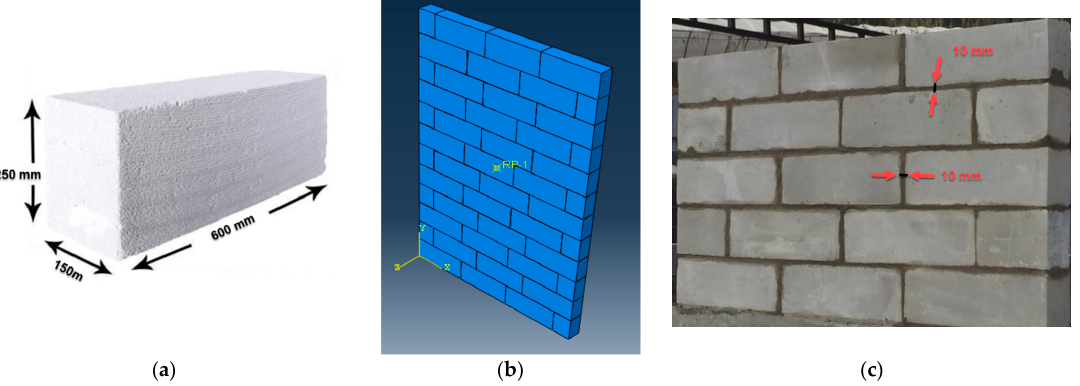
Figure 5. Specifications of the AAC wall and block model: ( a ) AAC block dimensions; ( b ) FE model of the wall; ( c ) assumed thickness of grout layer.